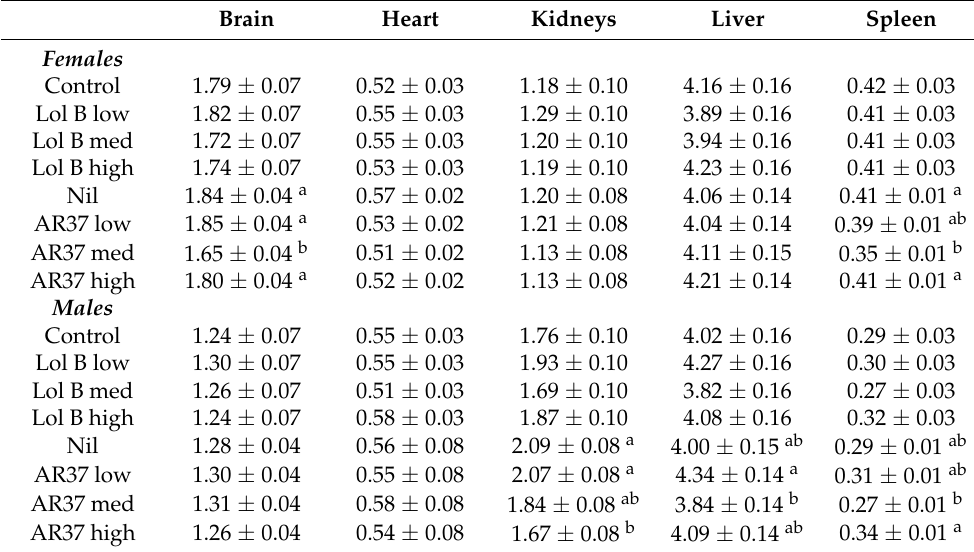
Table 9. Relative organ weight data (% of total bodyweight) for mice fed AR37 or lolitrem B containing treatment diets for 90